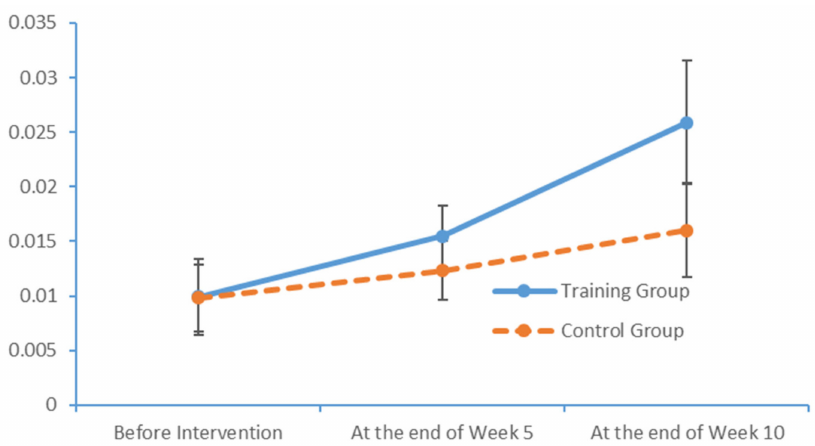
Figure 16. Changes in the power values of the beta_region_central wavebands measured in the two subject groups at several time